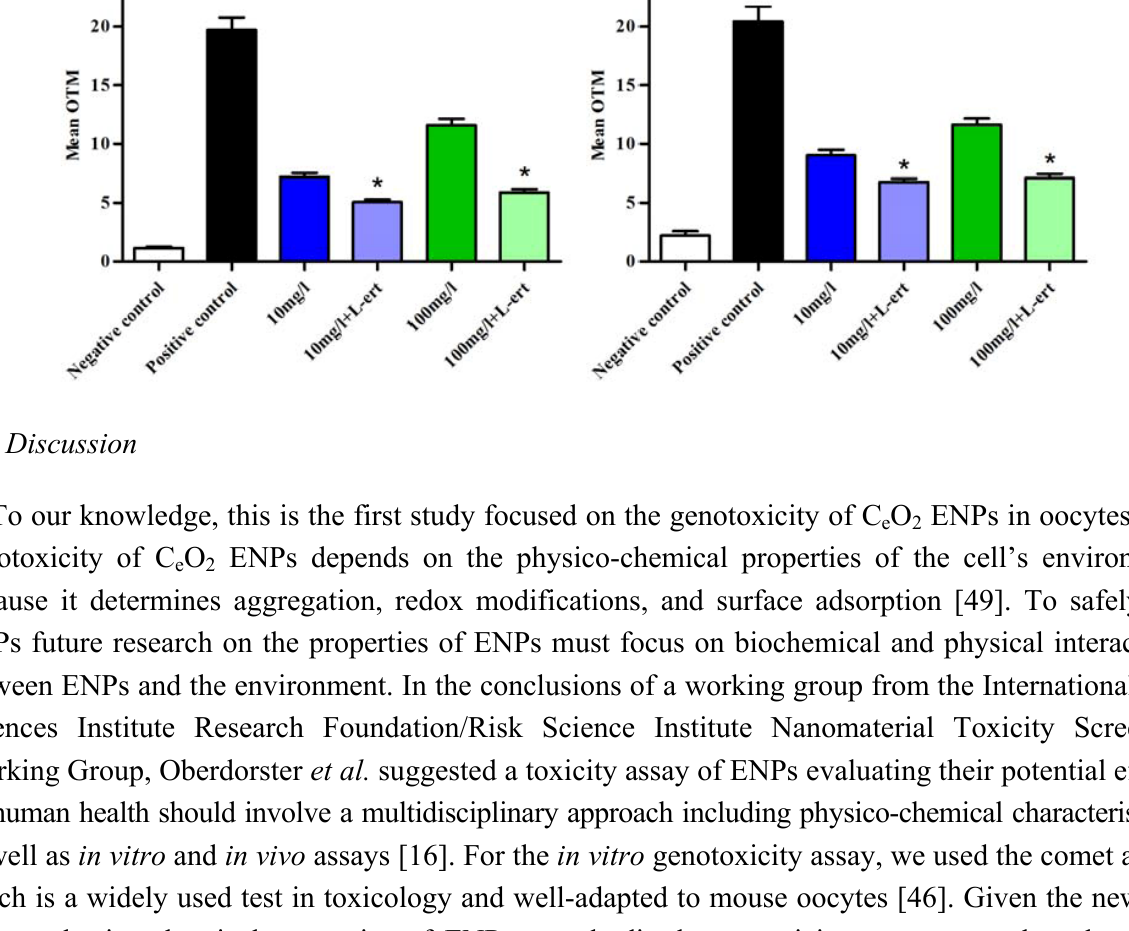
O ENPs using the comet assay after e 2